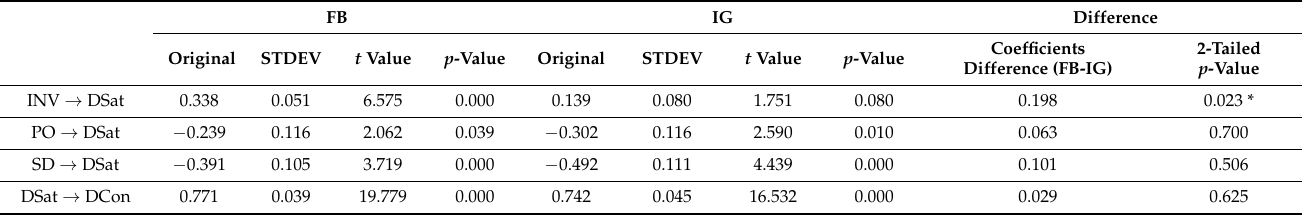
Table 7. Multi-group analysis of Facebook and Instagram users.